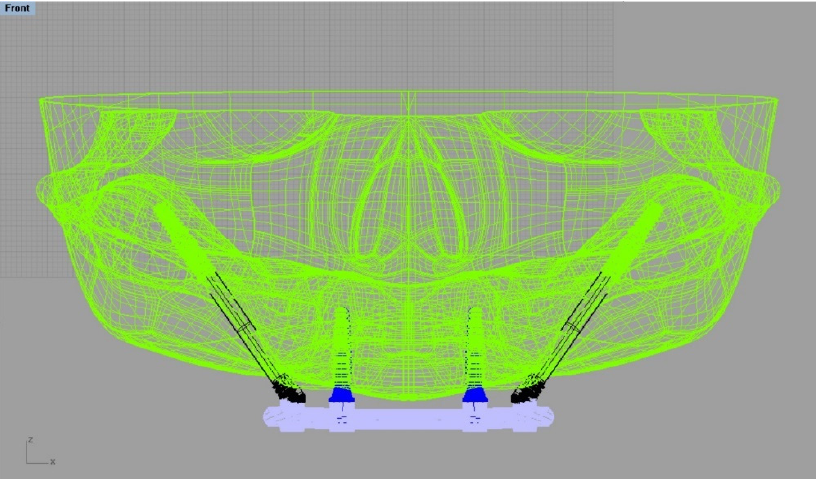
Figure 1. Polylines network in the CAD software created for three-dimensional modelling of a skull with fixation of the four implants. Anterior implants with conventional design and posterior implants as zygomatic implants.